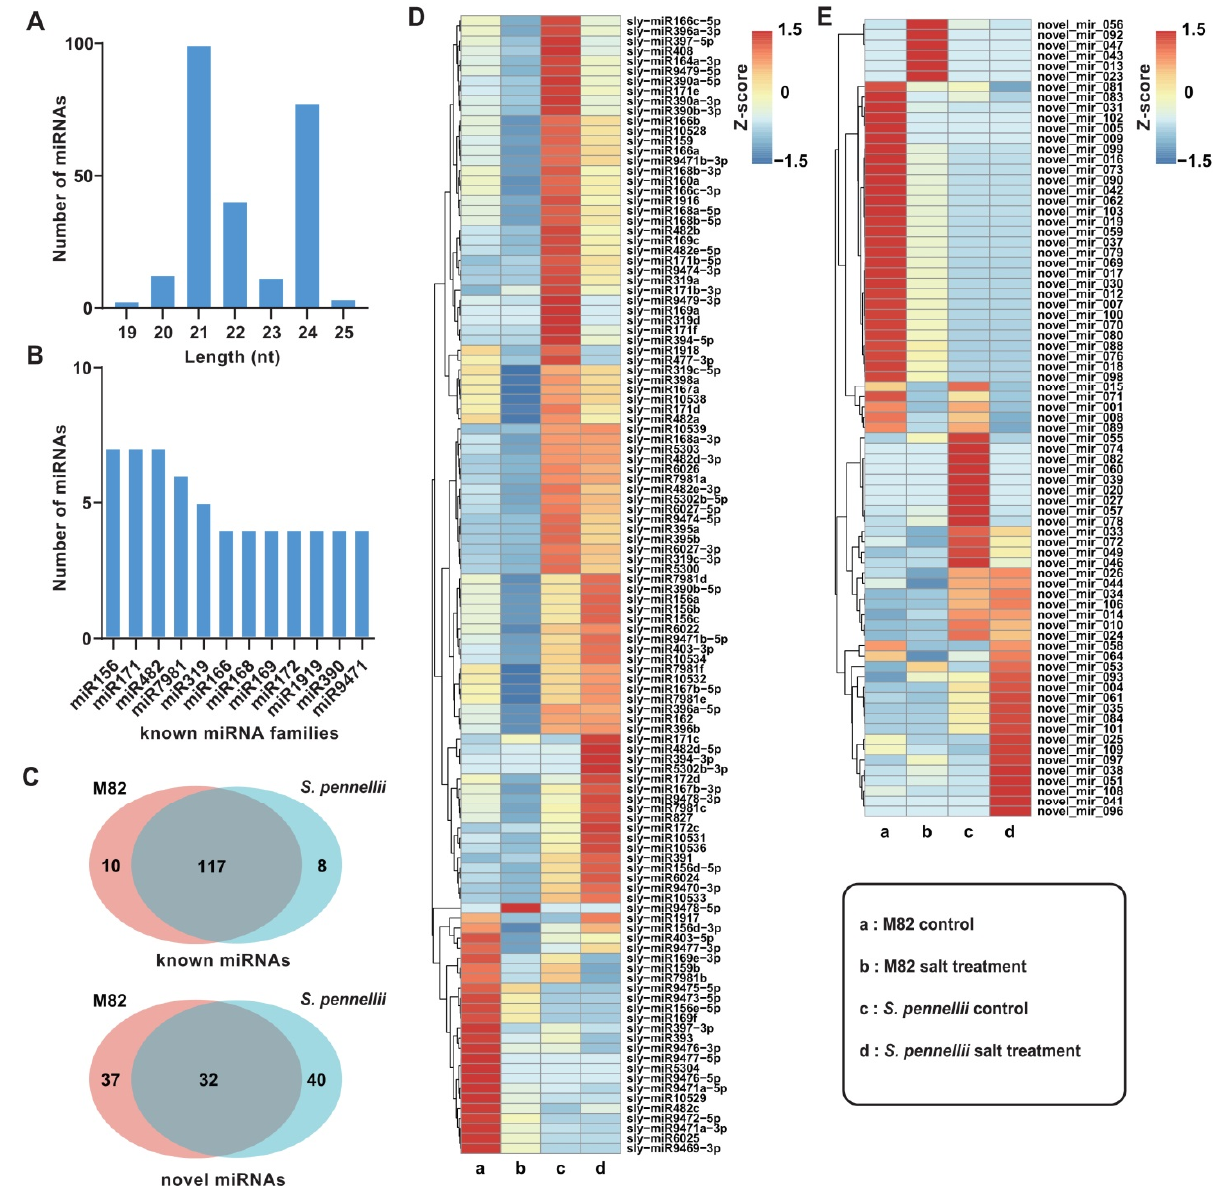
Figure 1. Identification and characterization of salt-responsive miRNAs. ( A ) The length distribution of salt-responsive miRNA read sequences. ( B ) The twelve conserved miRNA families had more than four members. ( C ) Venn diagram showing the intersection of miRNA expression in M82 and Solanum pennellii ( S. pennellii ). ( D ) Heatmap representing the expression profiles of the differentially expressed known miRNAs. ( E ) Heatmap representing the expression profiles of the differentially expressed novel miRNAs.